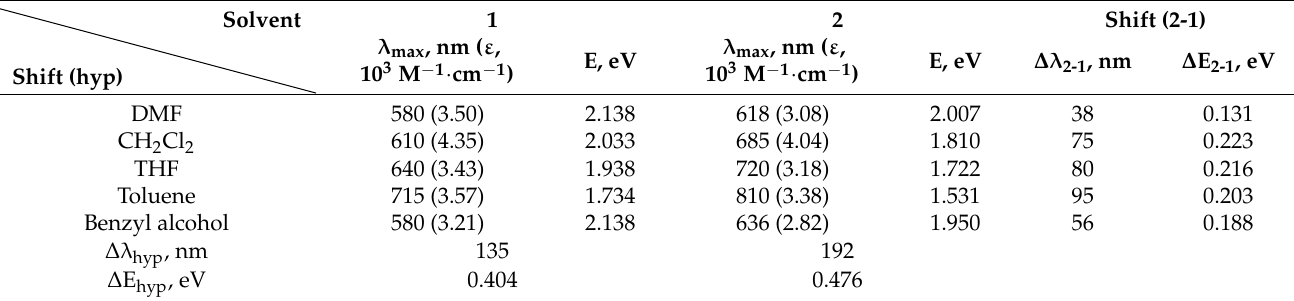
tive solvatochromism towards both Ni II derivatives with a considerable hypsochromic